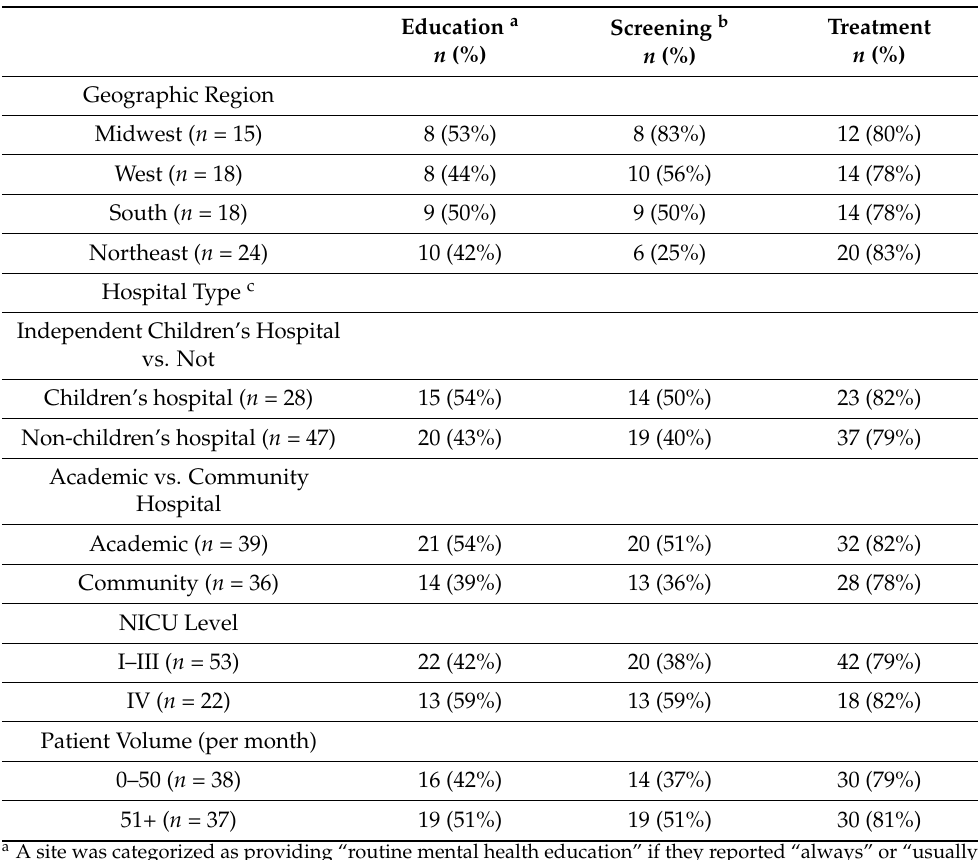
Table 3. Provision of routine mental health education, screening, and treatment, by NICU